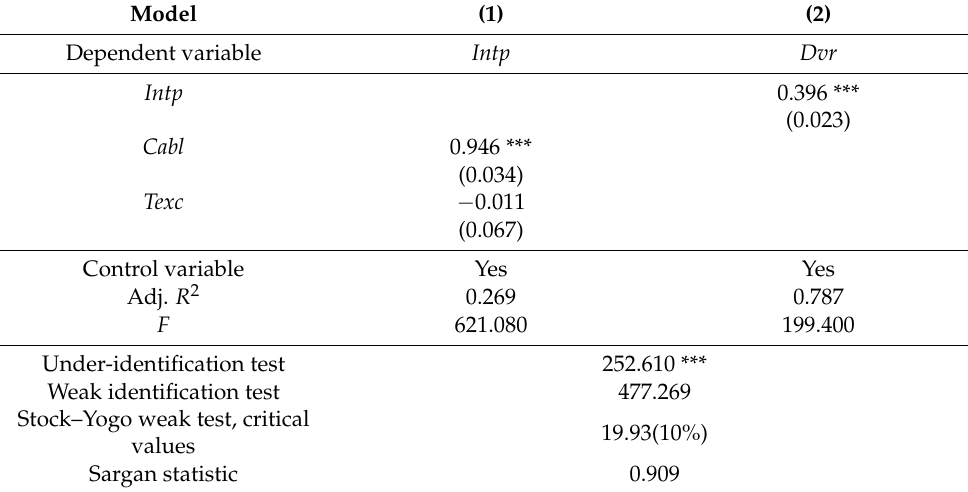
Table 10. Instrumental regression results for the effects of IPR on CDRs ( N =